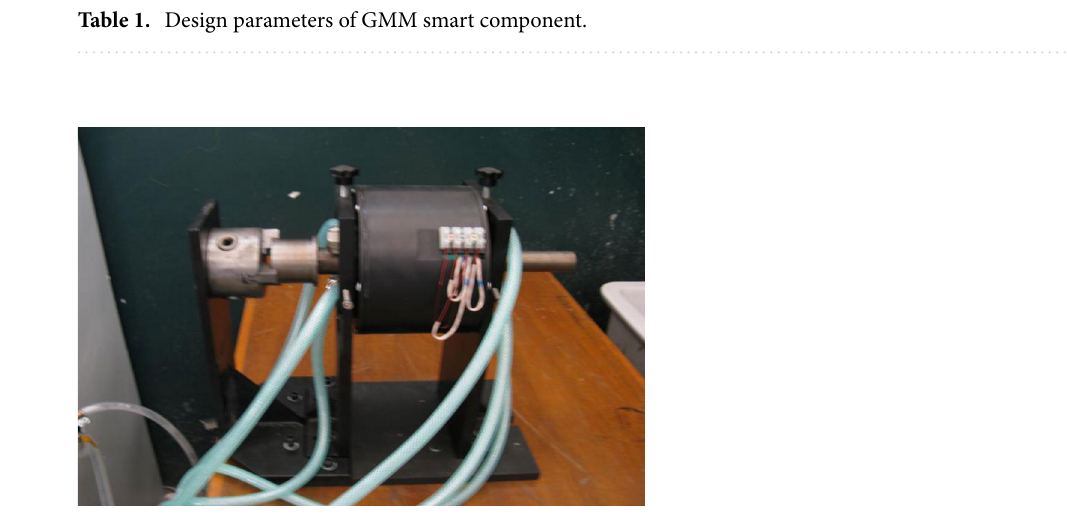
Figure 3. Smart component